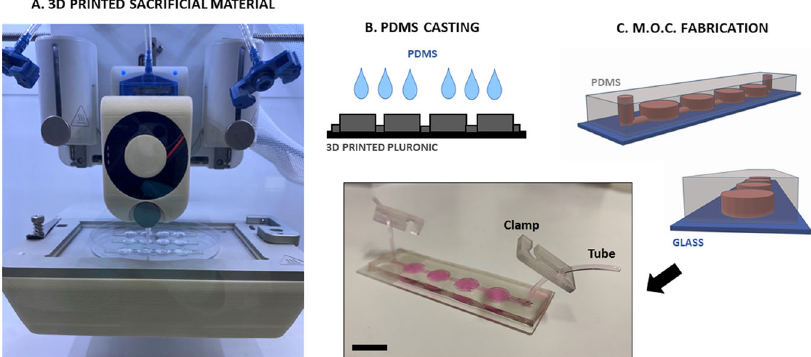
Fig. 1 Fabrication steps for MOC. A Pluronic F127 40% ink is printed on a standard petri dish. B PDMS is casted over the printed construct and let polymerized for an overnight. C The mold is peeled off and bonded on a glass slide. Picture (Copyright holder: Giulia Silvani) showing the real MOC containing media with tubing and clamp. Scale bars, 1 cm.